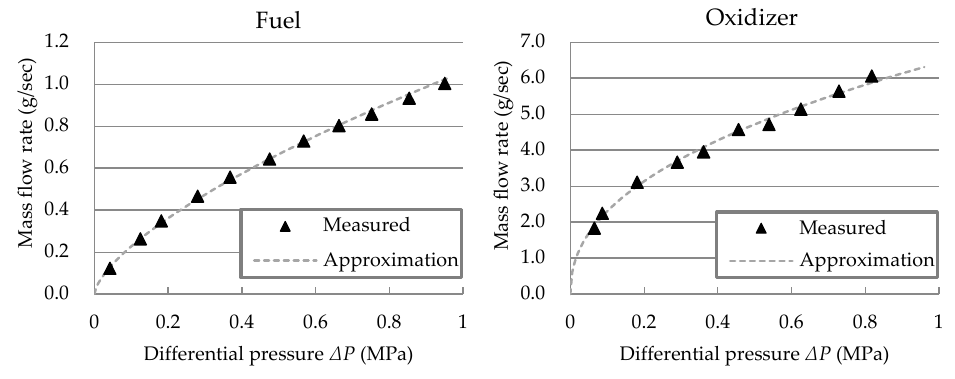
Figure 9. Shadowgraph images of injection spray by water (left: 0° angle, right: 90° angle). For the injector, the relational data of the injection differential pressure and mass flow rate were obtained in advance using actual fluid, and approximate equations were obtained . m = α ∆ P β . The results of the from the data by power-law approximation, described as mass flow calibration of the fuel and oxidizer are shown in Figure 10. Here, each test condition was tested only one time. The results of calculating α and β in the approximate equation are shown in Table 5. The coefficients of determination R 2 for both equations were larger than 0.99, indicating that they were approximated with high accuracy.